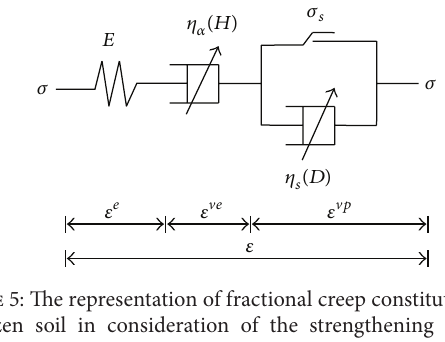
Figure 5: The representation of fractional creep constitutive model of frozen soil in consideration of the strengthening effect and weakening